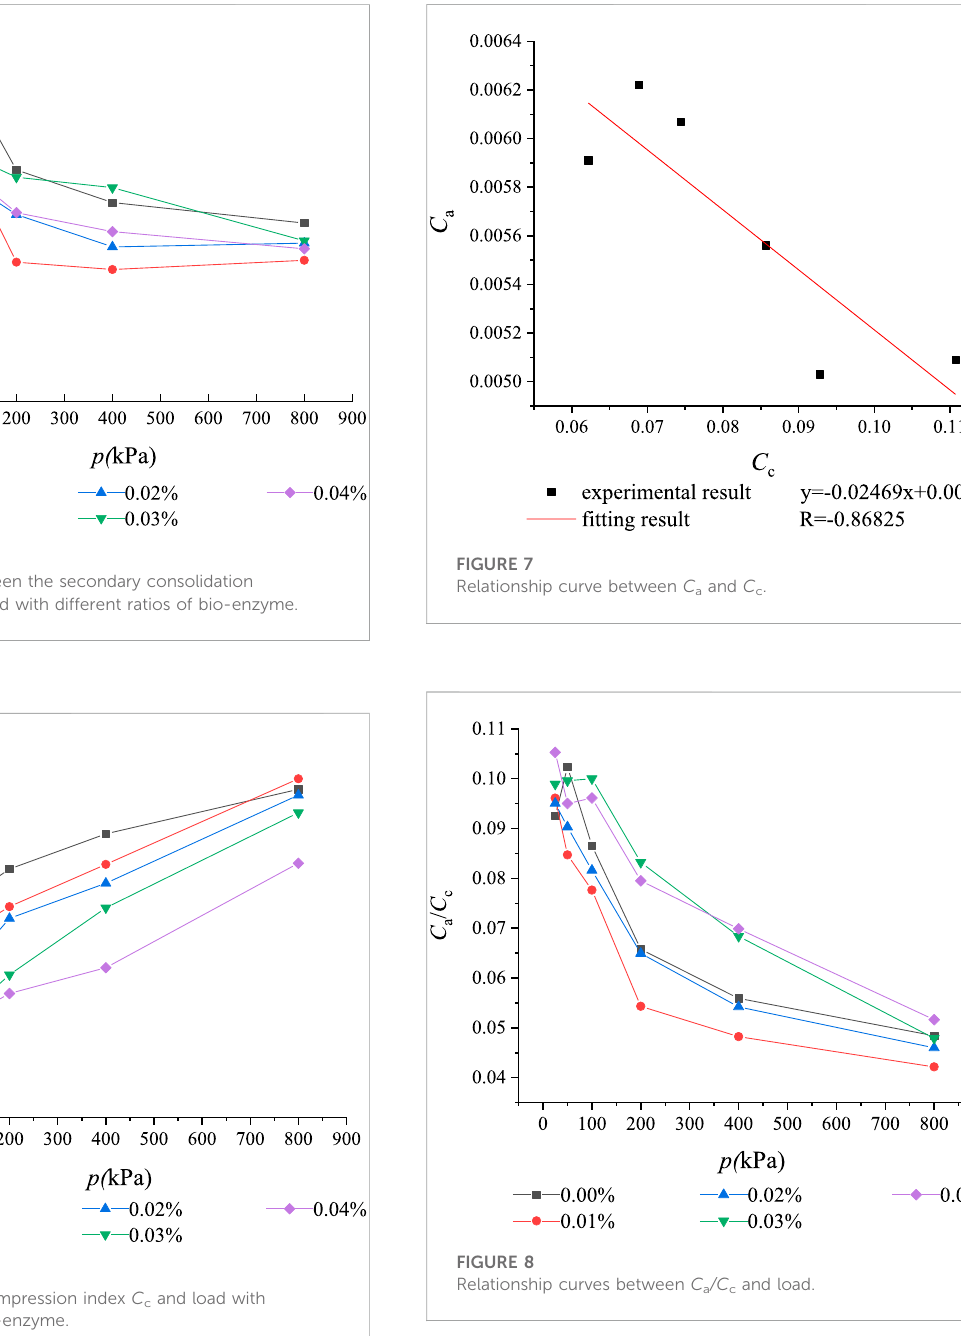
FIGURE 6 Relation curves of compression index C c and load with different ratios of bio-enzyme.